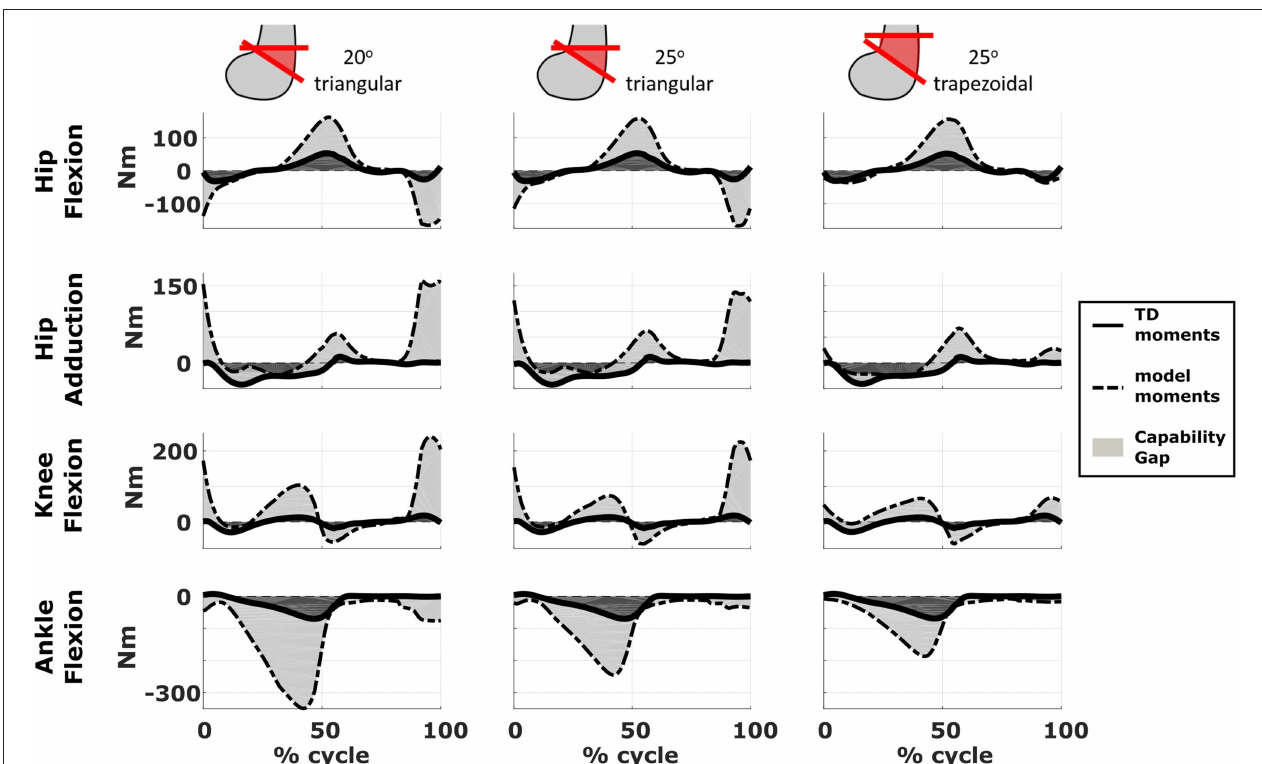
FIGURE 4 | Effect of treatment options on the capability gap. Data reported are relative to the simulated post-operative condition of the right leg of Patient 2. Capability gap is computed after rectus femoris transfer, femur extension and derotation osteotomy, and patella advancement interventions but before performing any muscle release intervention. The continuous black lines represent the joint moments required for the model to reach the desired kinematics [i.e., typically developed (TD) gait